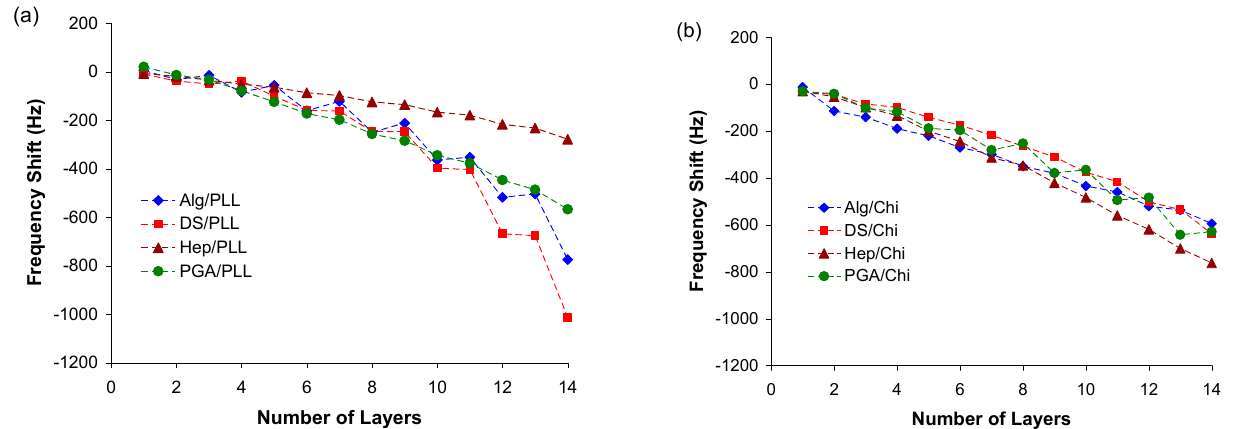
Figure 1. Cumulative QCM frequency shifts ( ∆ F ) of ( a ) polyanions/PLL adsorption and ( b ) polyanions/Chi adsorption on the gold-coated quartz crystal electrode. An odd number of layers represents either a PLL or Chi terminal layer and an even number of layers represents a polyanion terminal layer. Table 1. Static contact angle ( CA ), thickness ( L ), and measurements of 6.5 and 7 bilayers of each BioPEM component a